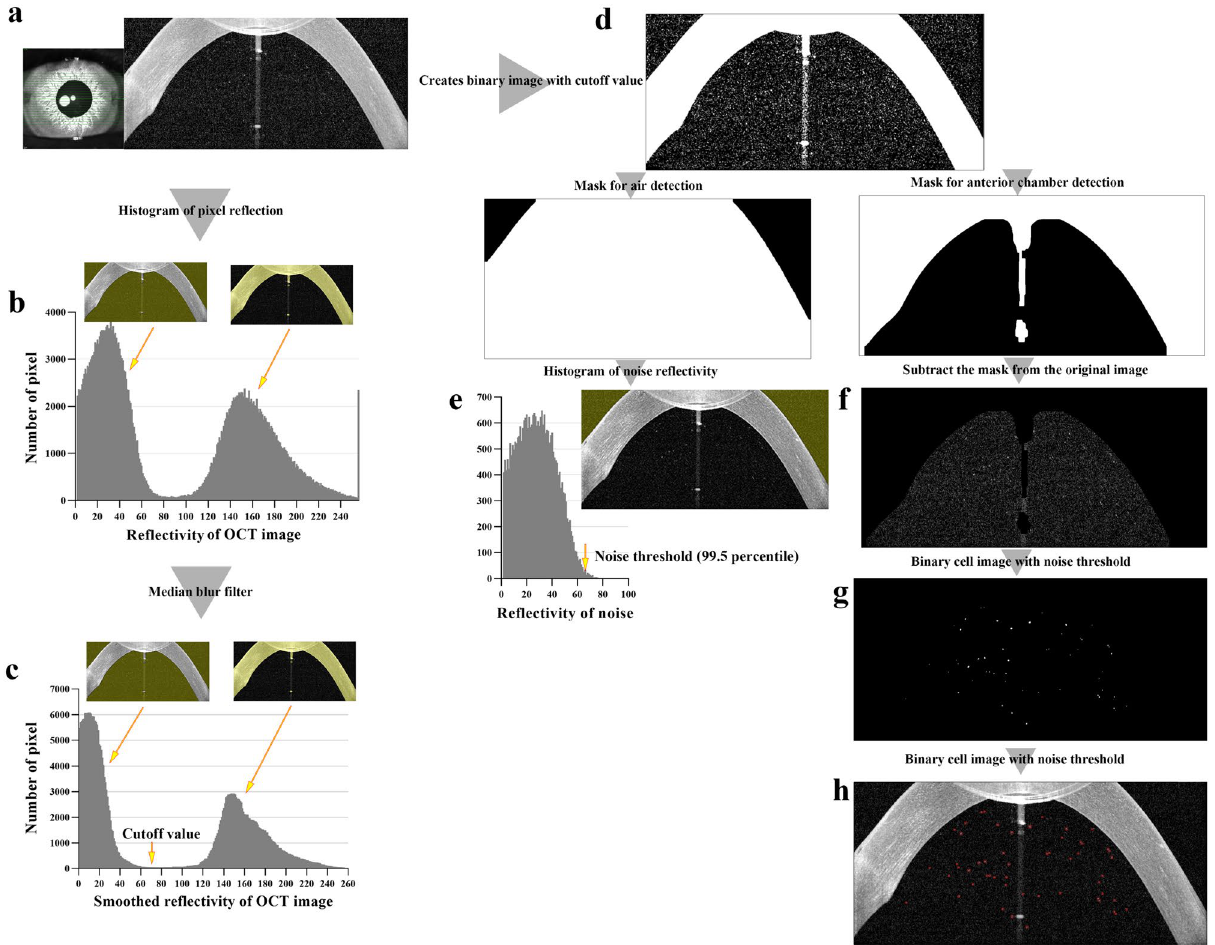
Figure 3. Schematic diagram of the method applied in this study. a The original image. Right image shows the current examination location with a bold green line, and left image shows air, cornea, and anterior chamber in order. The hyperreflective pixels in the anterior chamber are cells. Inverted artifacts in the cornea vertex and reflection artifacts in the center of the image are shown. b Histogram created using the entire pixel reflection. Noise-related pixels are clustered between 0 and 60, and hyperreflective pixels caused by the cornea, iris, and artifacts are clustered between 100 and 255. c After image smoothing with median blur, the histogram has more prominent two peaks and more apparent differences. d Generation of a mask corresponding to the cornea and artifacts. e Hyperreflective pixels in the air are referred to as noise. The histogram of these pixels does not fit the normal distribution. f Anterior chamber image after subtracting the cornea and air. g Binary image created based on the noise threshold. h The anterior chamber cell location was overlaid with color in the original image to verify the program was operating